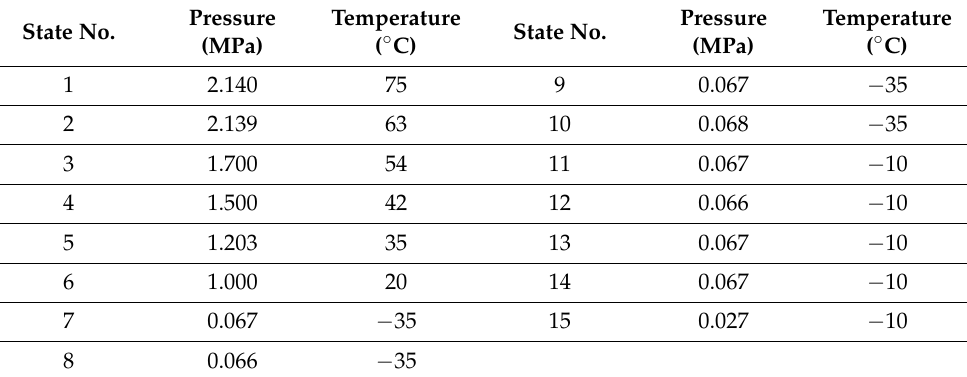
Table 5. Temperature and gauge pressure were monitored experimentally at various stages